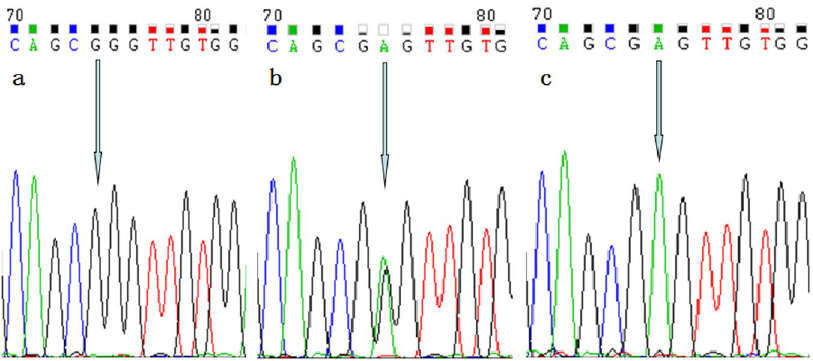
Figure 2. Sequencing map of the genotype for the TNFR2 rs1061624 polymorphism. Arrow in parts ( a – c ) indicates GG, G/A, and AA genotypes,